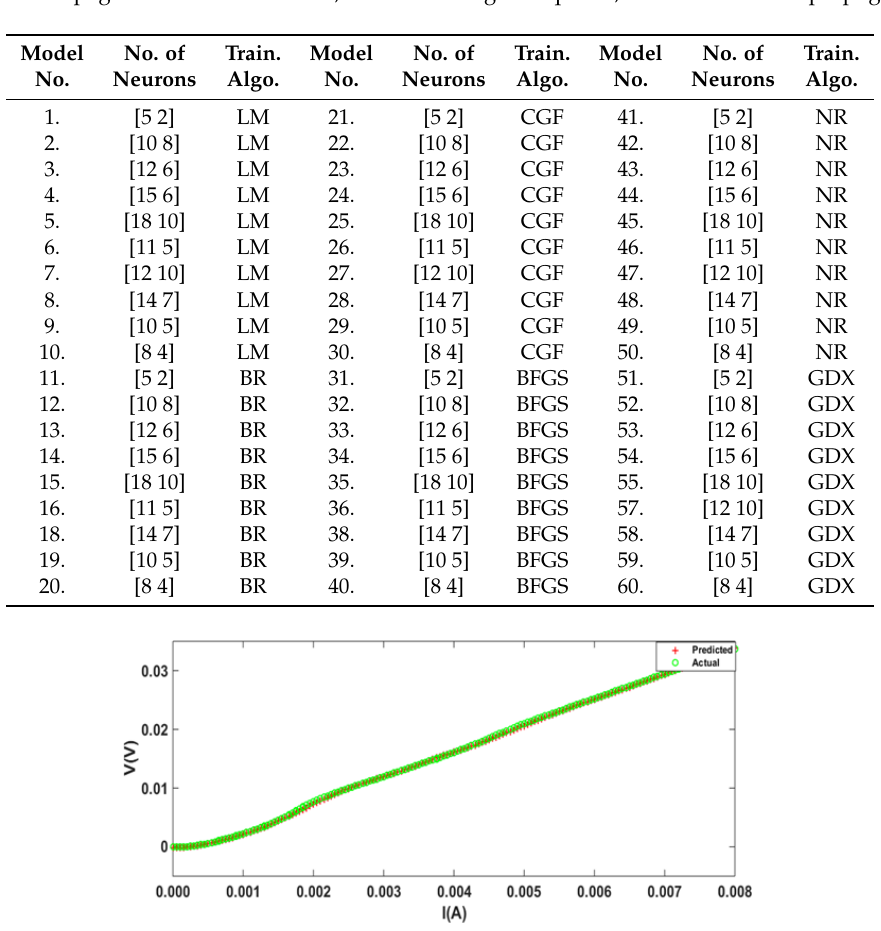
Sixty different ANN configurations for each architecture. BFGS: Quasi-Newton Backpropagation; BR: Bayesian Regularization; CGF: Conjugate Gradient; GDX: Variable Learning Rate Back Propagation with Momentum; LM: Levenberg–Marquardt; NR: Resilient Backpropogation.